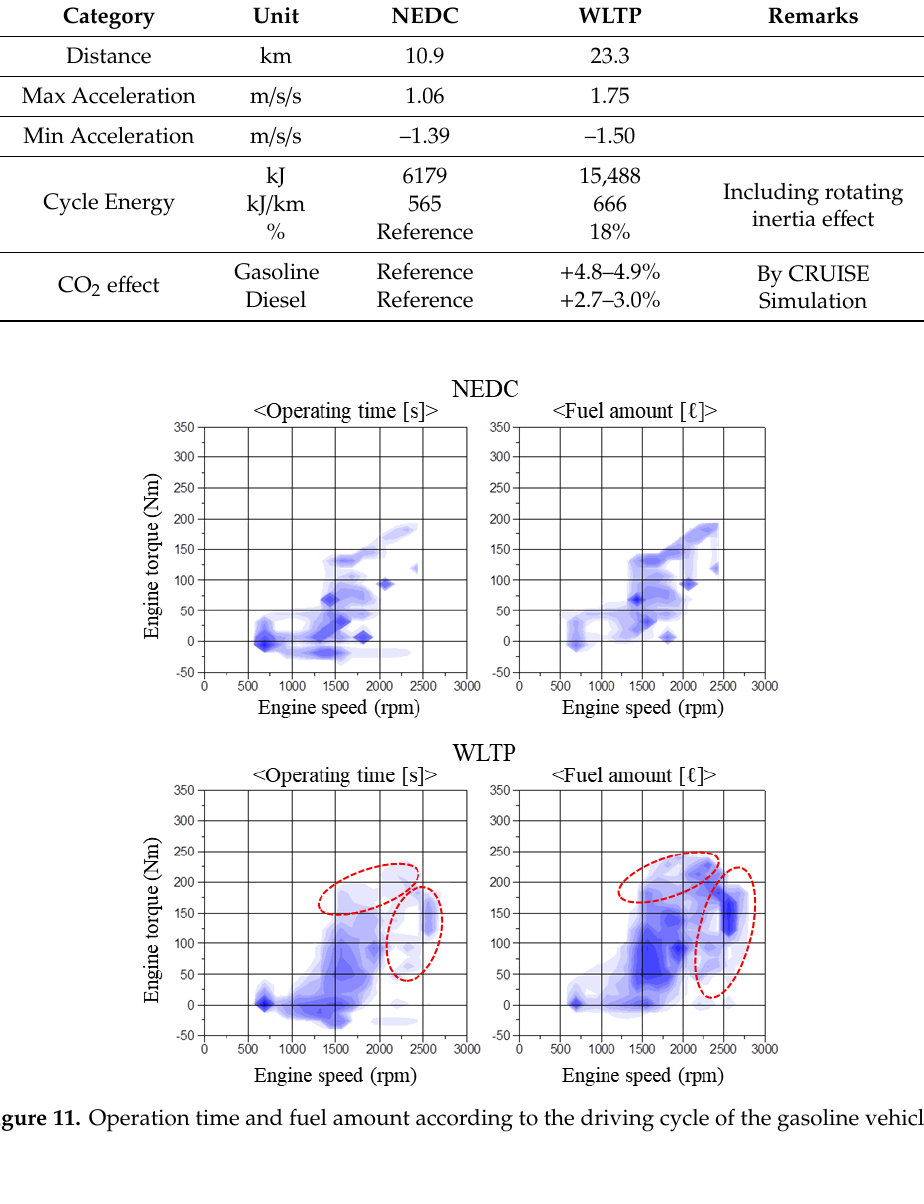
Table 6. Cycle energy and CO 2 effect by simulation according to the test mode (per test mass of 1718